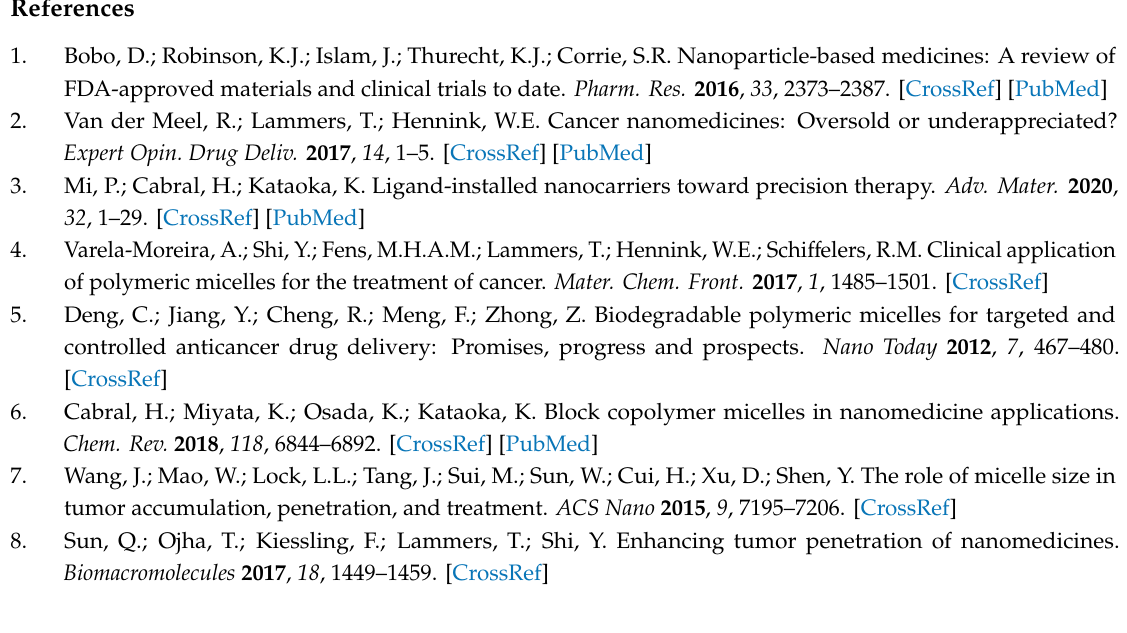
mPEG 5K - b -p(HPMA-Bz) 2.7K , Figure S5: Mixing time (ms) of NaOH and phenolphthalein solutions plotted against total flowrates, Table S1: Flow rates and their approximated mixing times as calculated using the information from Figure S5, Figure S6: PDI values of block copolymer D mPEG 5K - b -p(HPMA-Bz) 2.7K nanostructures as a function of mixing time, Figure S7: Rg / Rh traces of the AF4-MALS fractograms of nanoparticles made with block copolymer A mPEG 5K - b -p(HPMA-Bz) 17.1K with a concentration of 5 mg / mL at di ff erent microfluidic flow rates, Table S2: Characteristics of block copolymer B mPEG 5K - b -p(HPMA-Bz) 10.0K nanoparticles as determined by AF4-MALLS, Figure S8: Rg / Rh traces of the AF4-MALS fractograms of nanoparticles made with block copolymer B mPEG 5K - b -p(HPMA-Bz) 10.0K , Figure S9: Cryo-TEM pictures of block copolymer B mPEG 5K - b -p(HPMA-Bz) 10.0K nanoparticles at di ff erent flow rates, Table S3: Characteristics of block copolymer C mPEG 5K - b -p(HPMA-Bz) 5.2K nanoparticles as determined by AF4-MALLS, Figure S10: Rg / Rh traces of the AF4-MALS fractograms of nanoparticles made with block copolymer C mPEG 5K - b -p(HPMA-Bz) 5.2K , Figure S11: Cryo-TEM pictures of block copolymer C mPEG 5K - b -p(HPMA-Bz) 5.2K nanoparticles, Figure S12: Rg / Rh traces of the AF4-MALS fractograms of nanoparticles made with block copolymer D mPEG 5K - b -p(HPMA-Bz) 2.7K , Figure S13: Histograms of cryo-TEM diameters of block copolymer A (mPEG 5K - b -p(HPMA-Bz) 17.1K ) and block copolymer D (mPEG 5K - b -p(HPMA-Bz) 2.7K ) nanostructures, Figure S14: Histograms of cryo-TEM diameters of block copolymer B (mPEG 5K - b -p(HPMA-Bz) 10.0K ) and block copolymer C (mPEG 5K - b -p(HPMA-Bz) 5.2K ) nanostructures, Figure S15: Thermograms of p(HPMA-Bz) homopolymers corresponding to the di ff erent molecular weight block copolymers recorded by